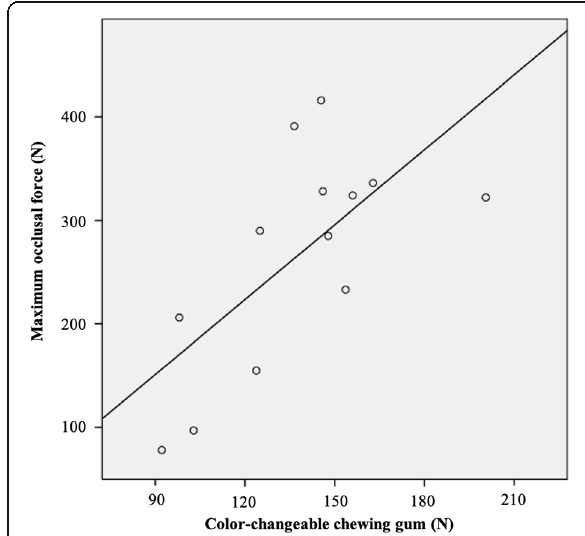
Fig. 2 The scatter diagram shows the relationship between maximum occlusal force and color-changeable chewing gum. Significant positive correlation was observed ( r = 0.676, P = 0.007) in a 5-year follow-up period. Solid line represents the regression line